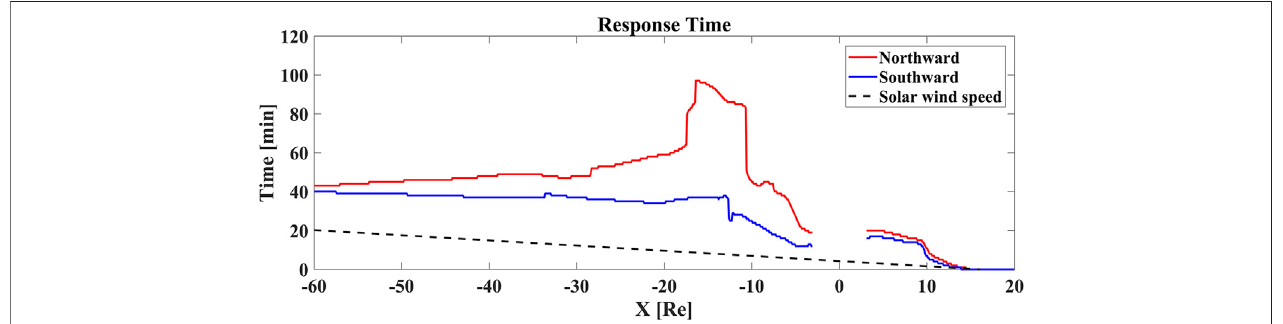
FIGURE 5 | Response time of the y-component of the geomagnetic fi eld variation on the Sun-Earth line under northward (red) and southward (blue) IMF B z conditions.